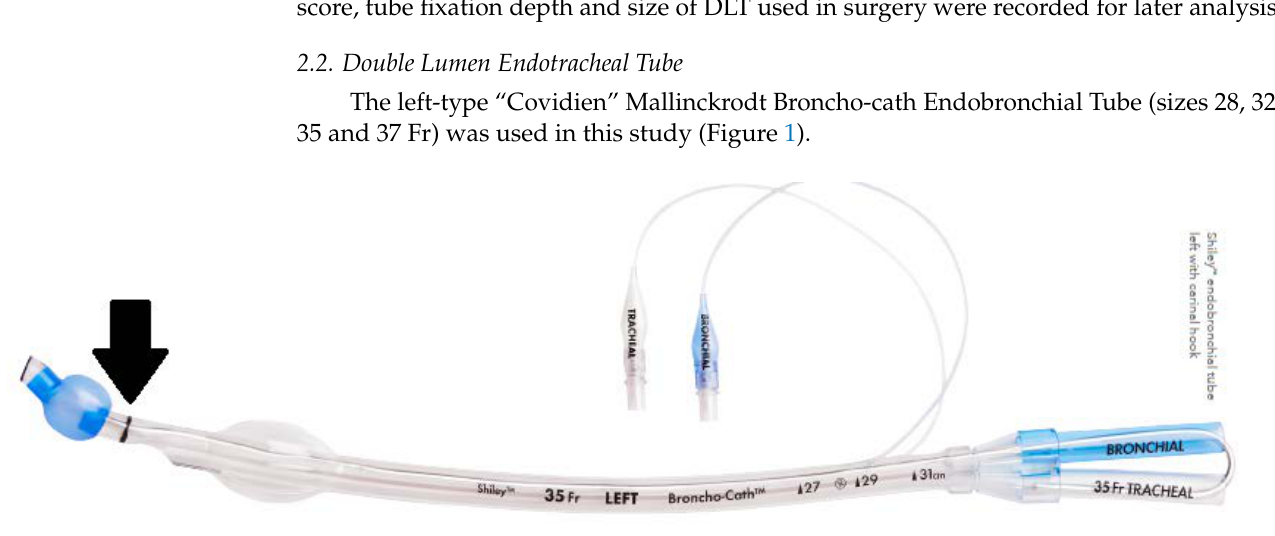
Figure 1. The outer diameter of a left DLT was measured using a caliper at the carina mark (indicated by the black arrow).